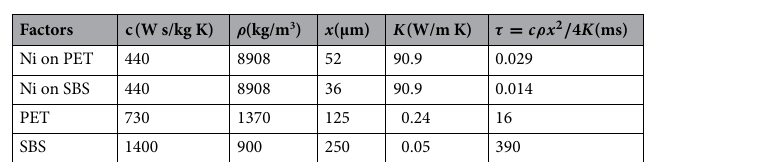
Table 1. The simulation parameters and the estimations of thermal equilibration times.